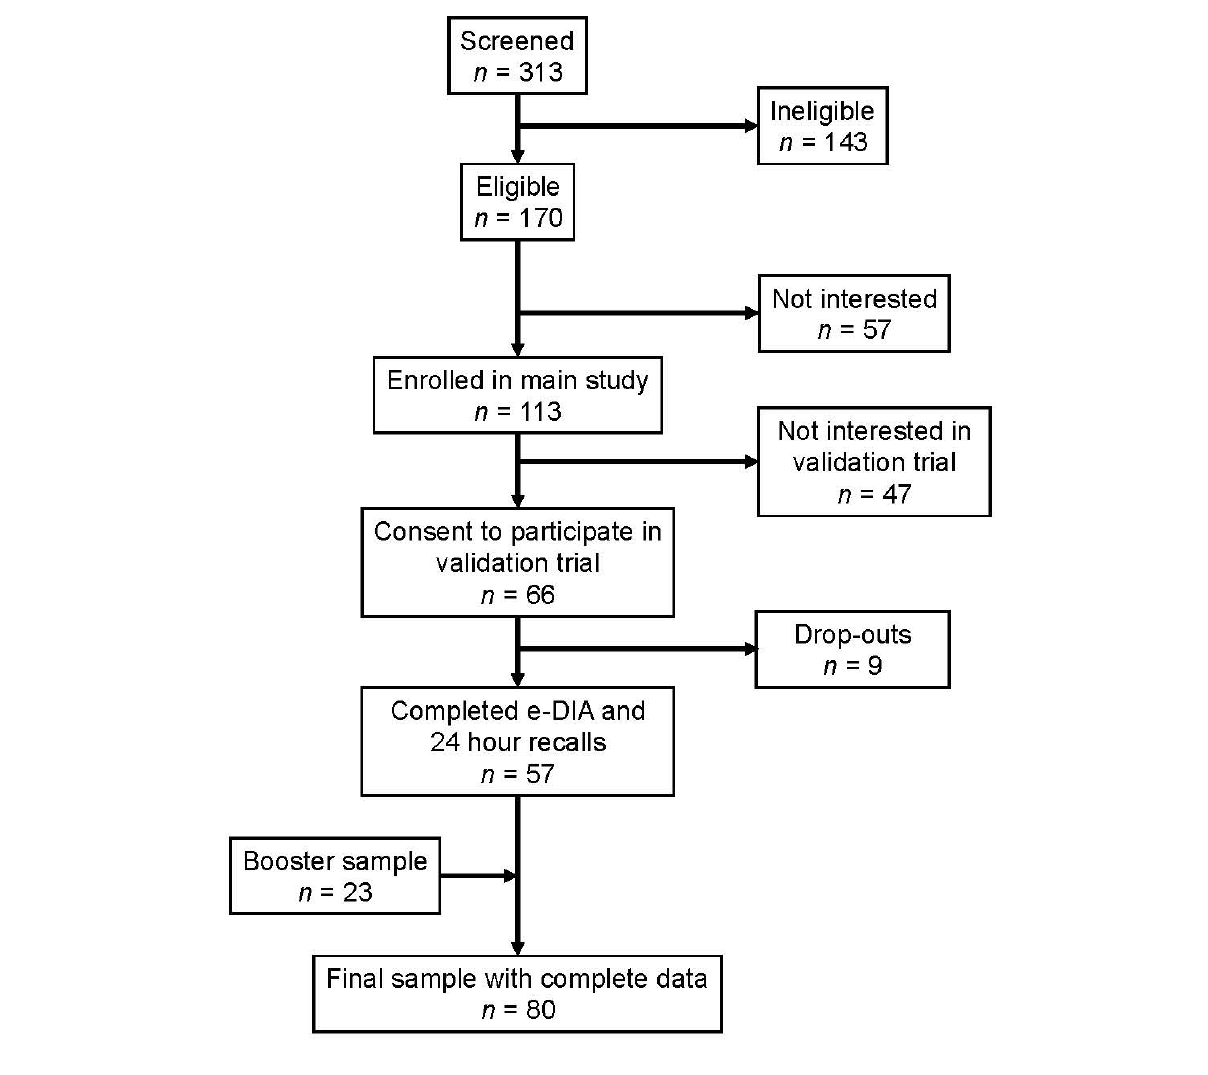
Figure 1. Flow chart of participant recruitment.